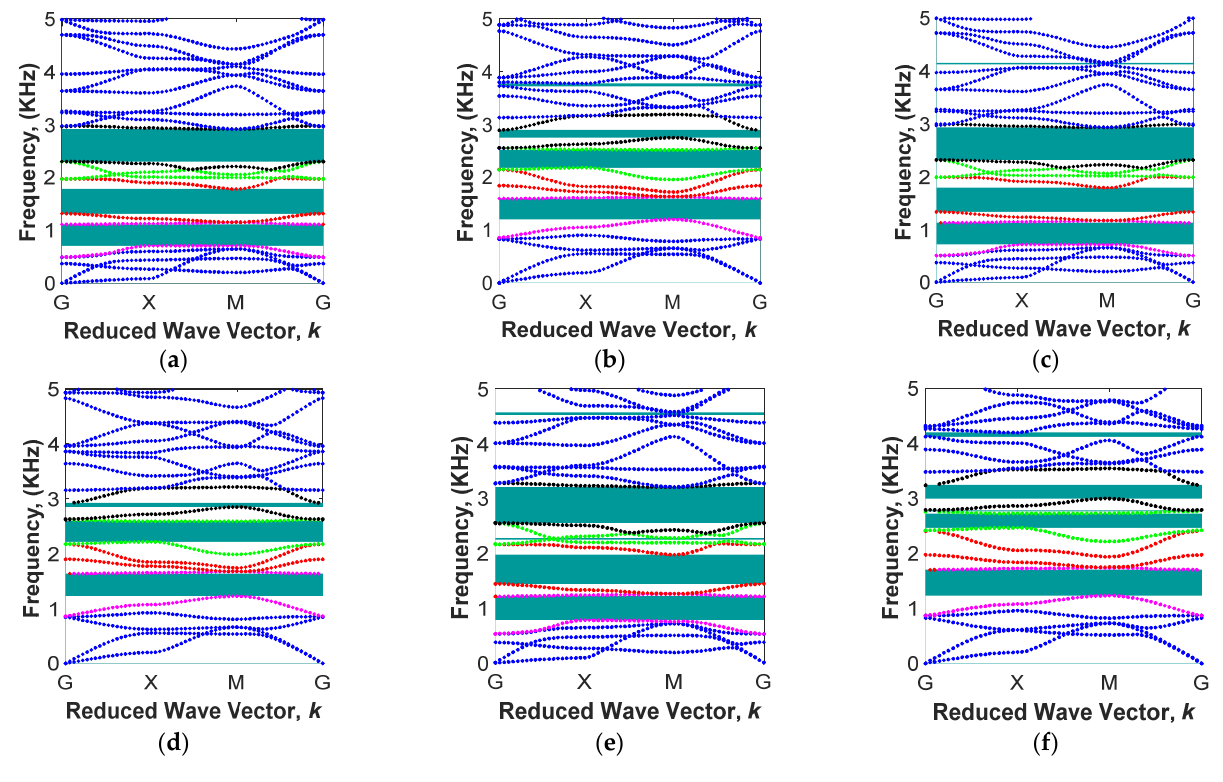
Figure 11. Active band structures in different magnetic fields in various volume fractions with the fixed cylindrical core radius of L / R = 5 and the fixed arm angle θ = 0: ( a ) φ = 6.08% & B = 75 mT; ( b ) φ = 6.08% & B = 225 mT; ( c ) φ = 13.94% & B = 75 mT; ( d ) φ = 13.94% & B = 225 mT; ( e ) φ = 18.48% & B = 75 mT; ( f ) φ = 18.48% and B = 225 mT (Fifth and Sixth mode shapes colored in purple and represent the first band gap; Seventh and eighth mode shapes colored in red and represent the second band gap; Ninth and tenth mode shapes colored in green and represent the third band gap; Eleventh and twelfth mode shapes colored in black and represent the fourth band